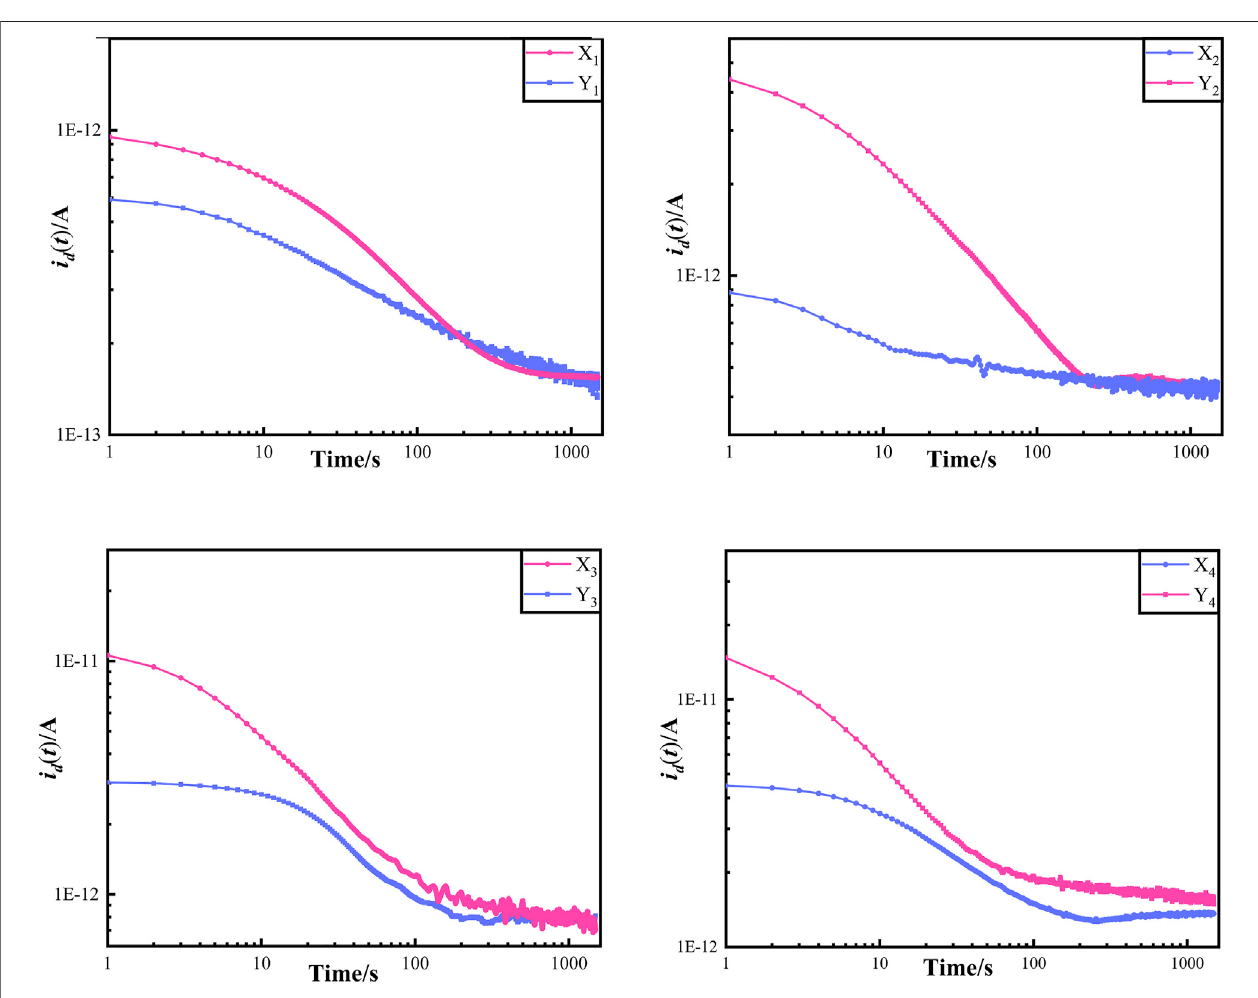
FIGURE 4 | PDC curve under different aging